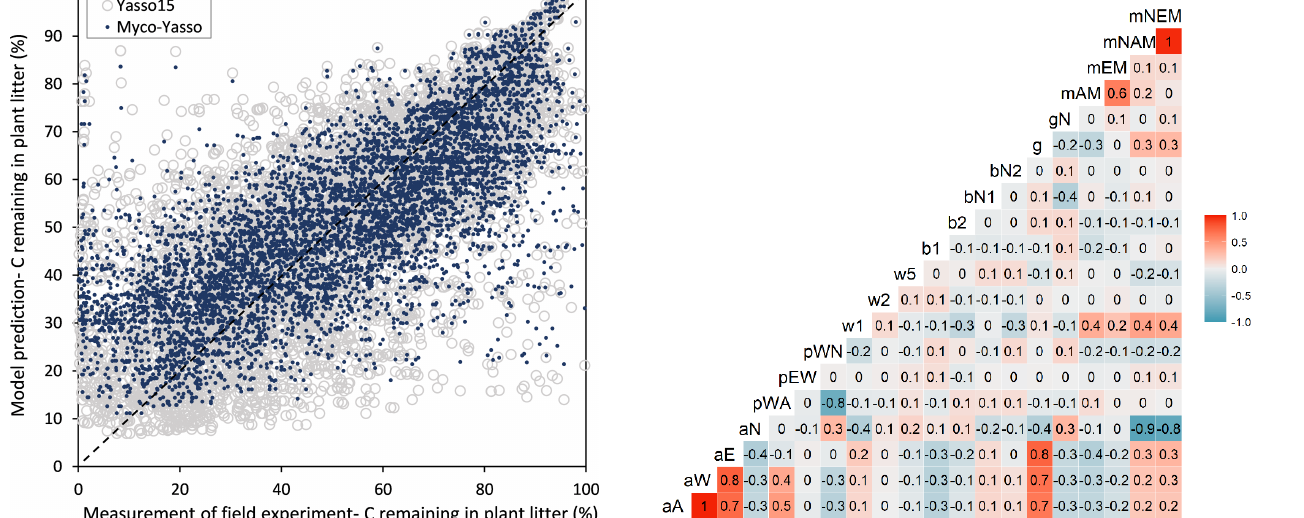
Figure C2. Correlations between parameters of the Myco-Yasso C model. The gradient from the most intensive blue colours to the most intensive red colours indicate correlations from completely negative ( − 1) to completely positive